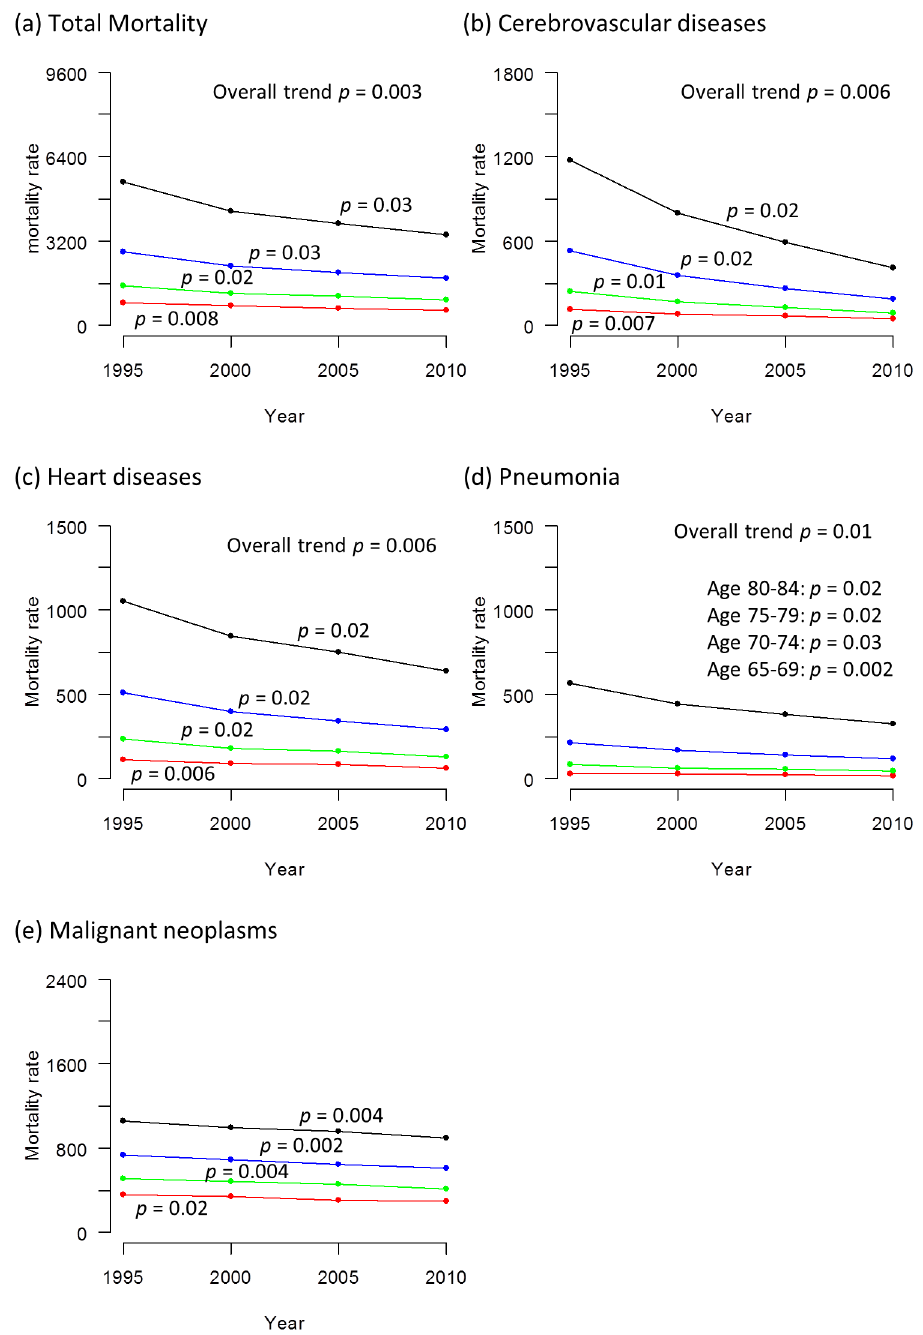
Fig 5. Trends in total mortality rate and mortality rates from specific causes in women from 1995 to 2010. (a) total mortality rate. Mortality rate from (b) cerebrovascular diseases (c) heart diseases (d) pneumonia (e) malignant neoplasms. The mortality rate is calculated as the number of deceased divided by the estimated population x 100,000. The black line represents those aged 80 – 84 years, the blue line represents those aged 75 – 79 years, the green line represents those aged 70 – 74 years and the red line represents those aged 65 – 69 years. The p values signify statistical significance for the trends in each age